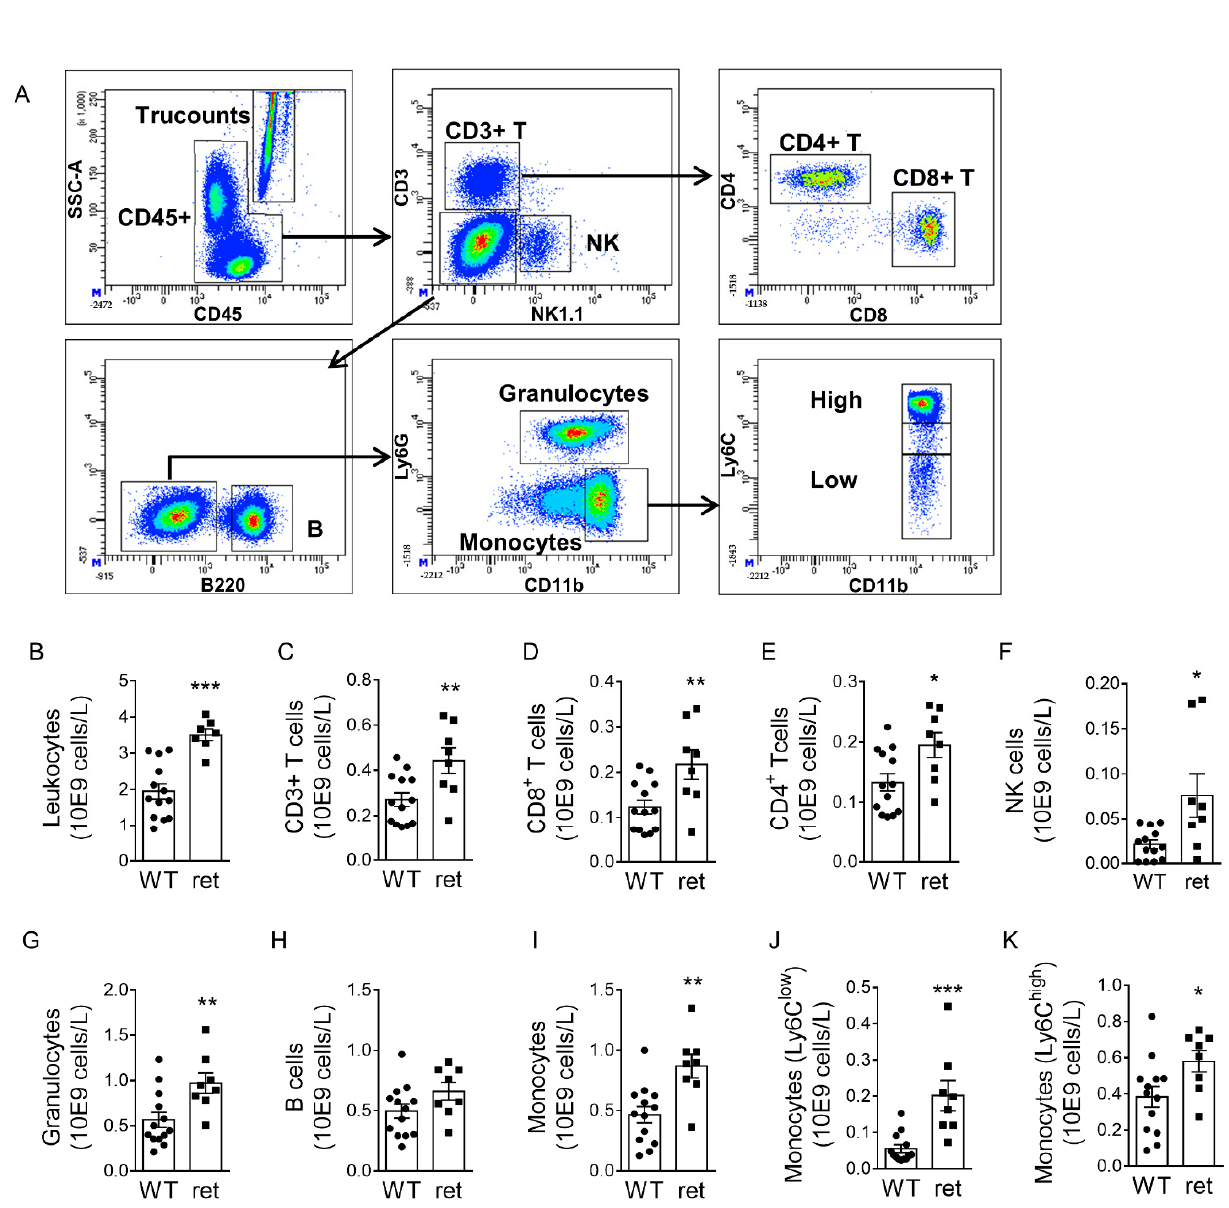
Figure 4. General leukocytosis in Pdgfb ret / ret mice. ( A ) Flow cytometry gating strategy to assess absolute circulating leukocyte counts. ( B – K ) Absolute numbers of CD45+ leukocytes; CD3+, CD8+ and CD4+ T cells; NK (natural killer) cells; granulocytes; B cells and Ly6C low and Ly6C high monocytes in Pdgfb WT / WT ( n = 13) and Pdgfb ret / ret ( n = 8) blood. Graphs represent mean ± SEM. * p < 0.05, ** p < 0.01, *** p < 0.001. Data were tested for normality (Shapiro-Wilk) and equal variances (F-test). Variables that did or did not pass were analyzed using Student’s t -test or the Mann-Whitney U test, respectively.